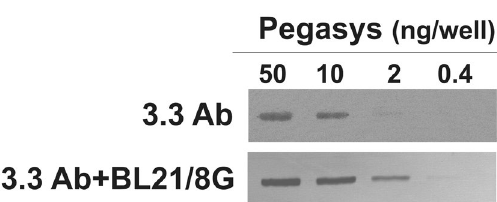
Figure 7. Western blot of PEG-conjugated IFN- α (Pegasys). Serially diluted Pegasys samples were electrophoresed on a 10% (w/v) reducing SDS-PAGE, transferred to nitrocellulose membrane, and probed with anti-PEG antibody (3.3) mixed with BL21/8G cells (lower panel) or not mixed with BL21/8G cells (upper panel) as described in the Materials and Methods